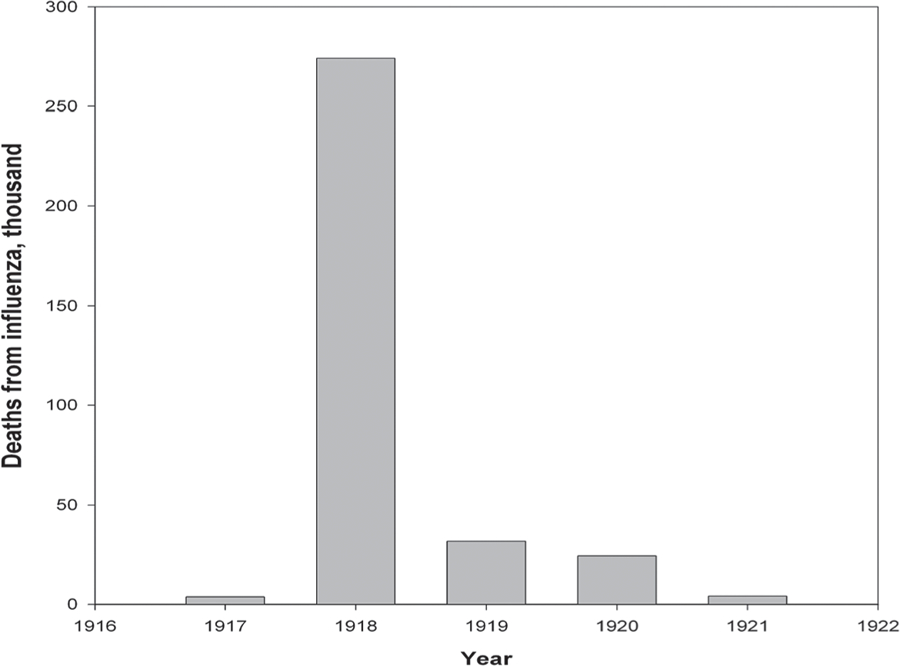
Deaths from influenza in Italy (in thousand), by calendar year. Source:
MAIC 1924, 1925a, 1925b